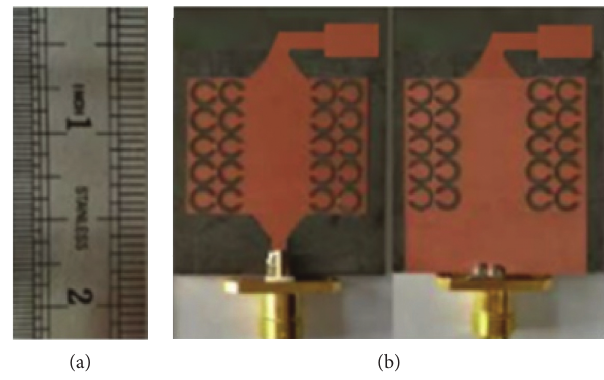
Figure 10: The photo of the antenna. (a) Top and (b) bottom.